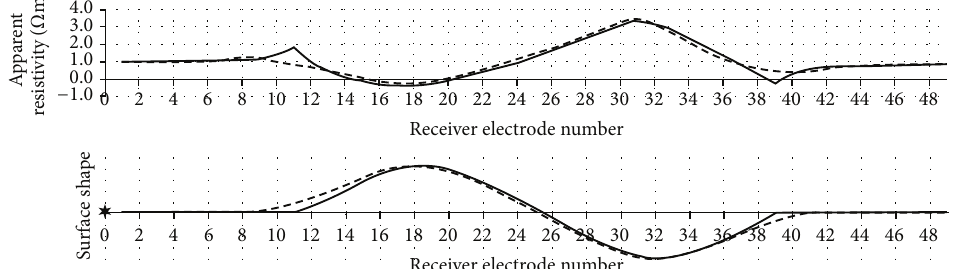
Figure 5: The form of the ground surface and 𝜌 𝑎 curves for a three-electrode array where the model surface has both positive (hemispherical convexity) and negative (hemispherical recess) shapes. A star indicates the position of the current source electrode. — indicates surface with sharp angles; ---- indicates surface with smooth corners.